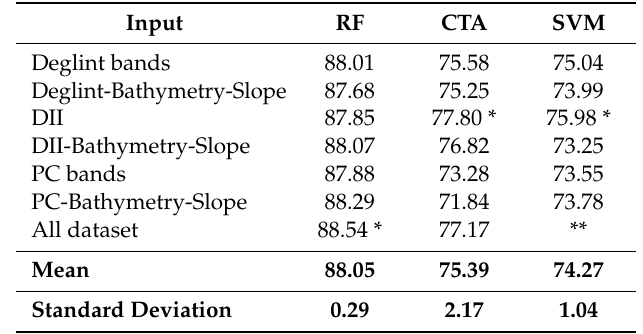
Table 7. Overall accuracy (OA) of classification results (%) in Kemujan Island. * depicts the highest classification accuracy for each classification algorithm. ** we failed to obtain the classification result of SVM using all dataset as input due to computational issues. RF model produced the highest and most consistent classification accuracy using di ff erent